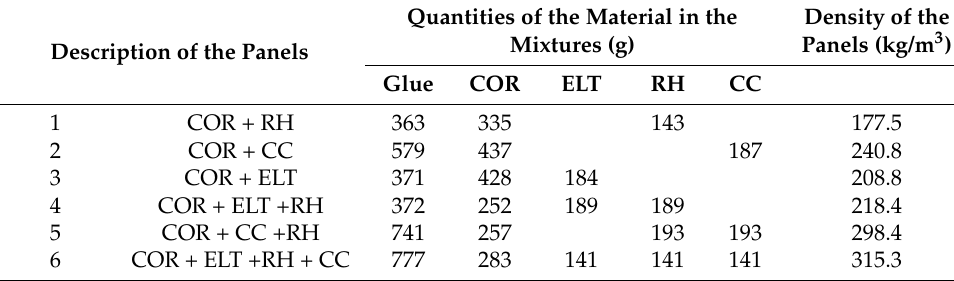
Description of the